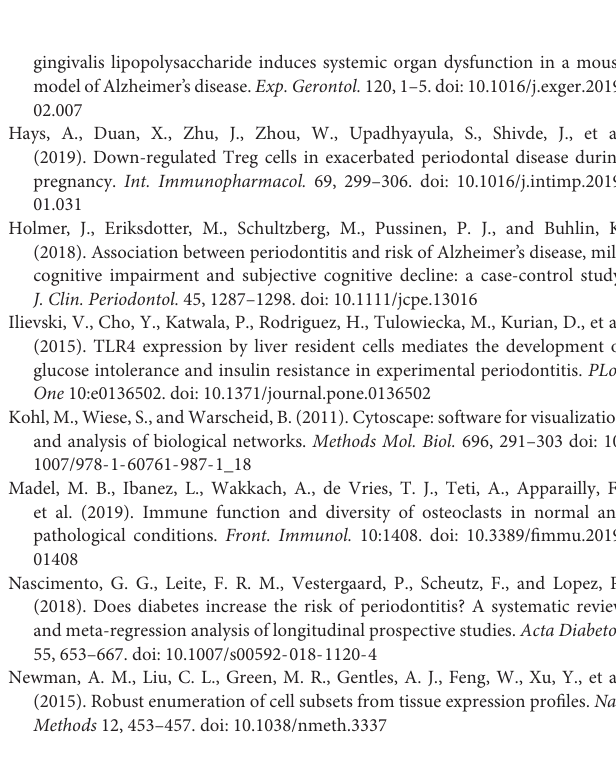
FIGURE S1 | Flow chart of the study design. FIGURE S2 | PCA analysis in DEMGs. TABLE S1 | Immune related lncRNA between periodontitis and health. TABLE S2 | Gene signature matrix in 22 human immune cell